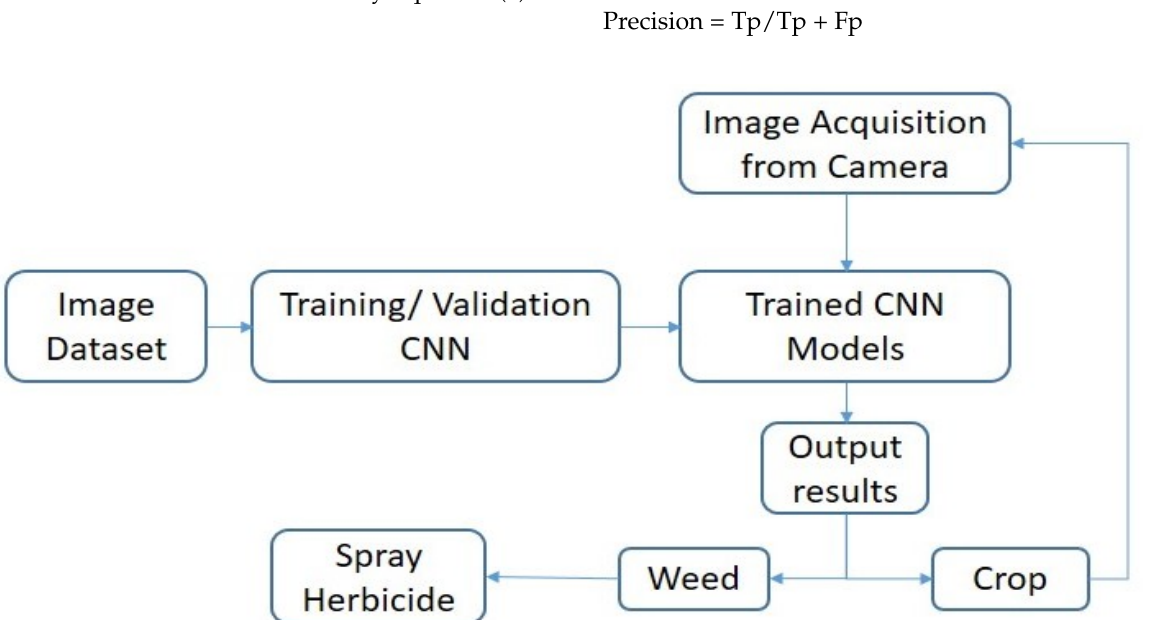
Figure 4. Schematic diagram of weed classification model.